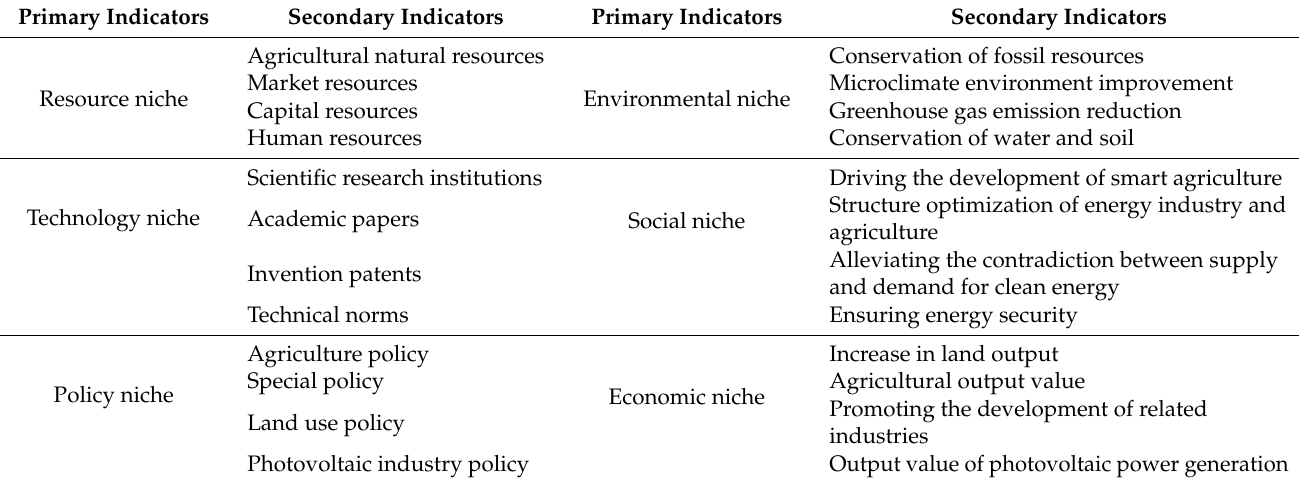
Table 4. Final niche evaluation index system of photovoltaic